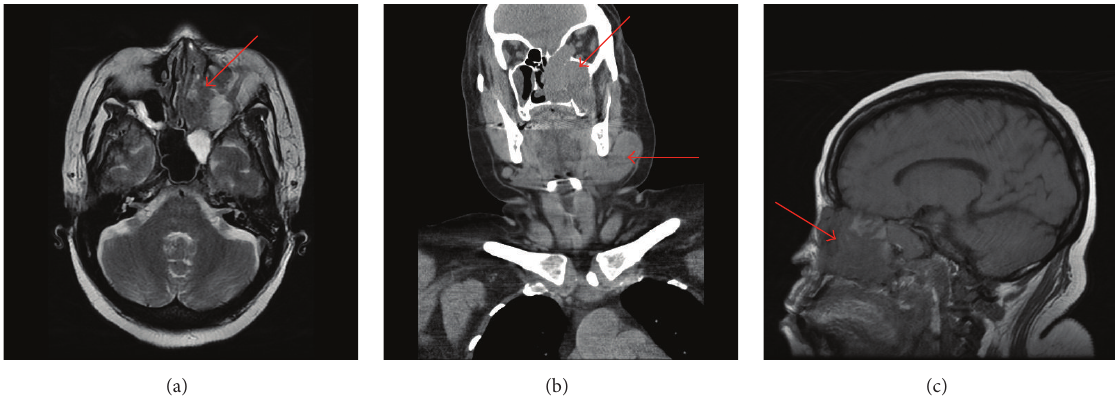
Figure 1: ((a) (axial), (b) (coronal), and (c) (sagittal)) CT scan of the neck showing extensive lymphadenopathy, left greater than right, and extensive soft tissue involving the left nasal cavity and multiple paranasal sinuses wit invasion into the left orbit and left infratemporal fossa.